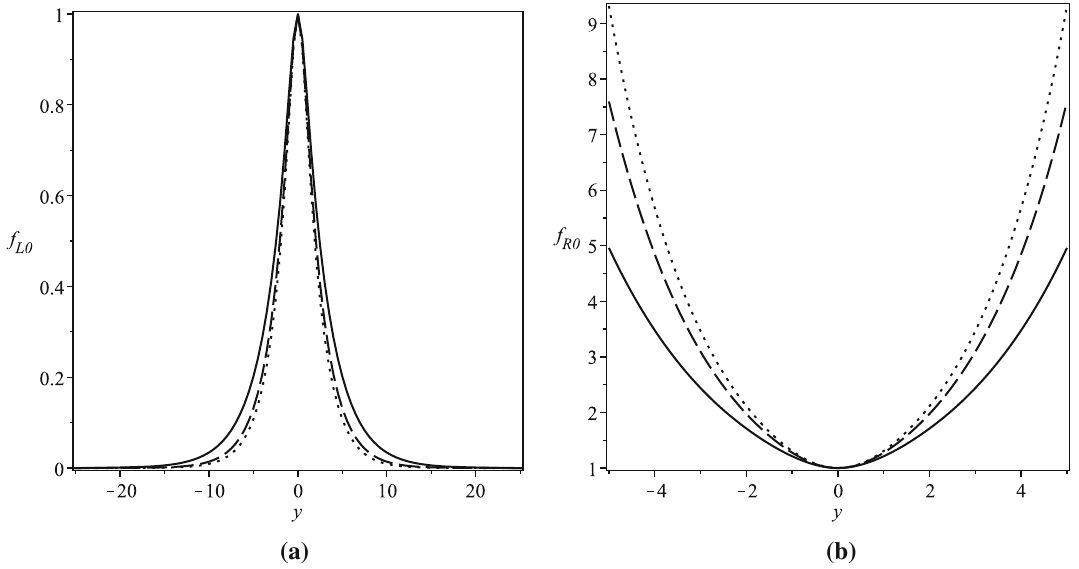
Fig. 9 The profile of the potentials a V L ( y ) and b V R ( y ) for a = 1 (solid line), a = 2 (dashed line), a = 5 (dotted line), η = 1